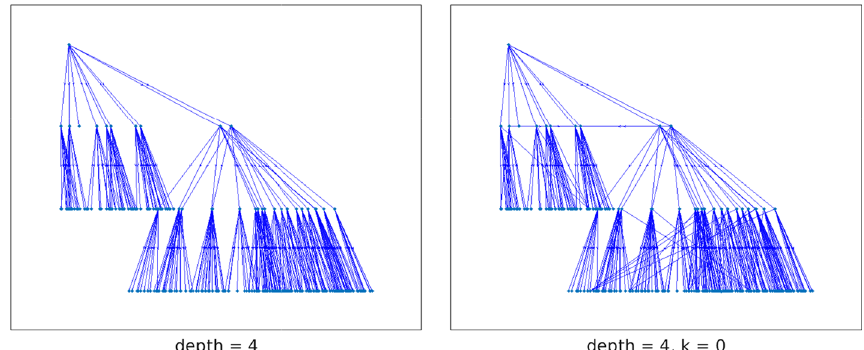
Fig. 12 Network n2c6b10: out-tree T 28 out and graph C ( T 28 out